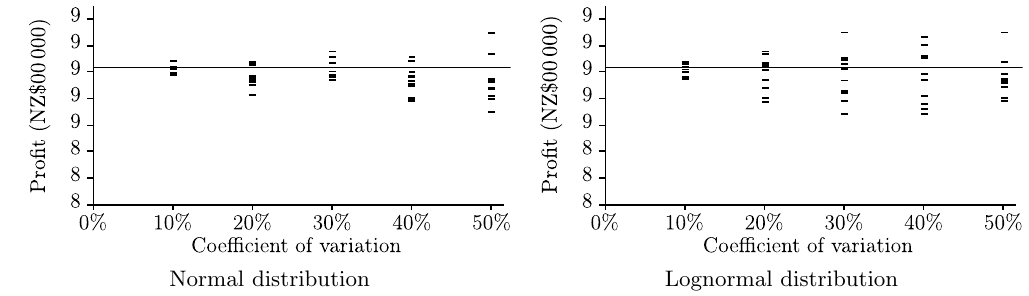
Figure 8: Fluctuation in the profit of a 10-period model of IFPM due to variability in catch rate with different means in different periods. The deterministic solutions are shown in dotted